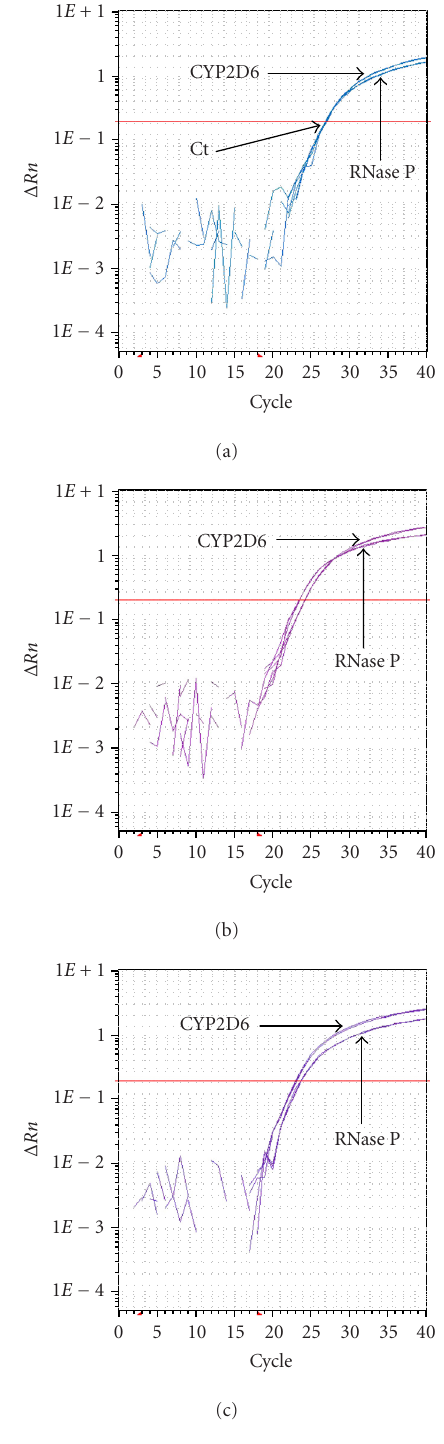
Figure 4. Amplification plots of CYP2D6 and RNase P genes. The ∆ Rn (reflecting the quantity of fluorescent probe degraded) is plotted versus cycle number. (a) Samples with 2 copies of CYP2D6. In (c) samples with a duplication, the Ct value of CYP2D6 decreased compared to RNase P whereas in (b) samples with deletion, the Ct value of CYP2D6 increased compared to RNase